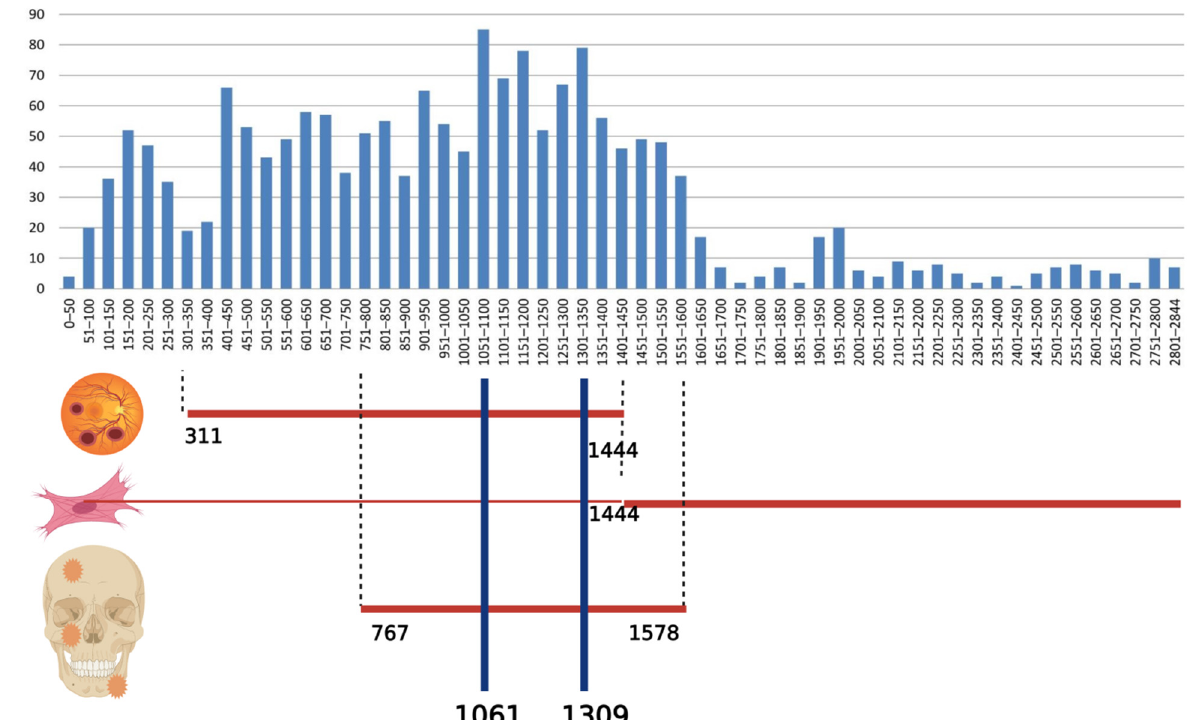
Figure 5. Distribution of germline mutations in APC gene (data from the online database HGMD ® Professional 2021.1, accessed on 26 June 2021) and correlation with congenital hypertrophy of the retinal pigment epithelium, desmoid tumors and osteomas. The abscissa represents the APC codon number and the ordinate represents the number of different mutations. Created with BioRender.com.